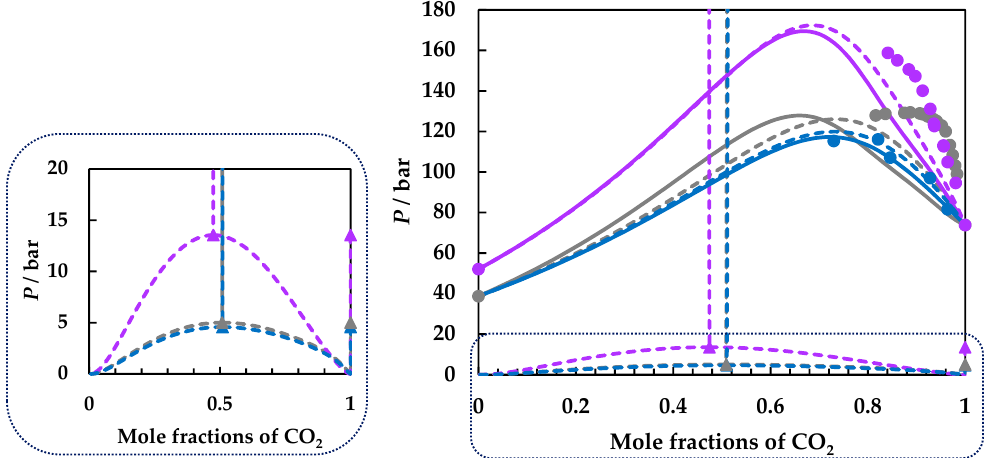
Figure 7. P – X fluid phase diagram of the carbon dioxide + ethyl acetate ( blue ), carbon dioxide + 1,4-dioxane ( purple ), and carbon dioxide + 1.2-dimethoxyethane ( gray ) binary systems. Symbols, literature data [22,51,53]; full lines, predictions by GEOS; dashed lines, predictions by PR EoS.